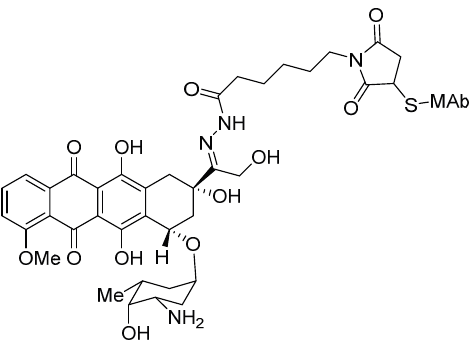
Figure 5. The structural formula of BR96-doxorubicin. Adapted from Reference